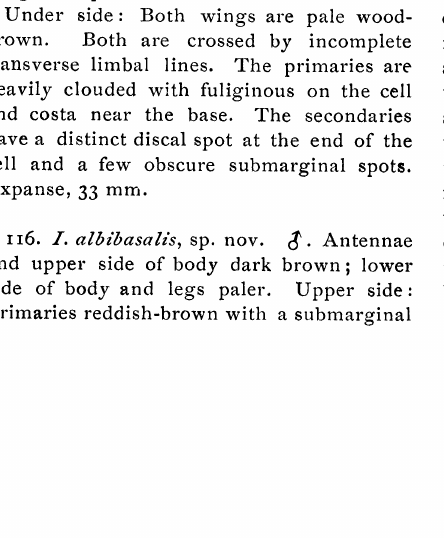
above pale reddish-brown: under side of